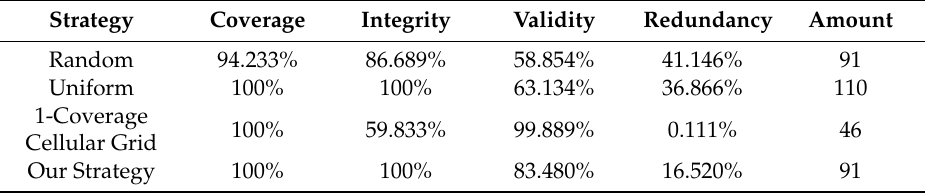
Table 2. Comparison of the quality of service (QoS) of the four node deployment